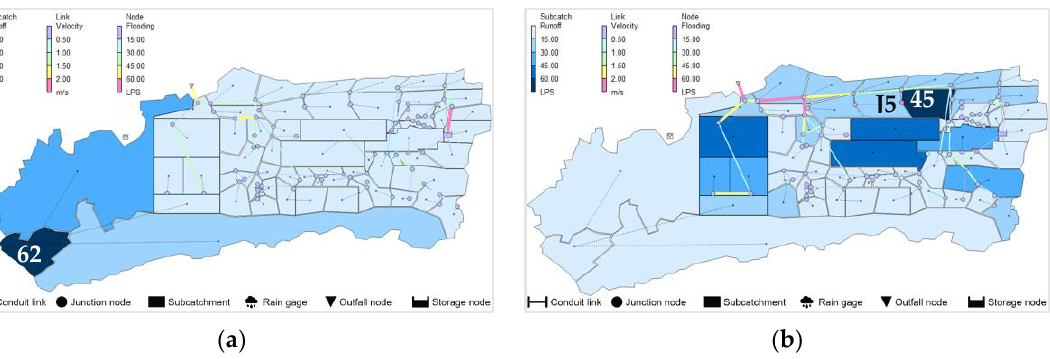
Figure 12. ( a ) Calculation results after the model precipitation ends; ( b ) calculation results 24 min after the precipitation starts.